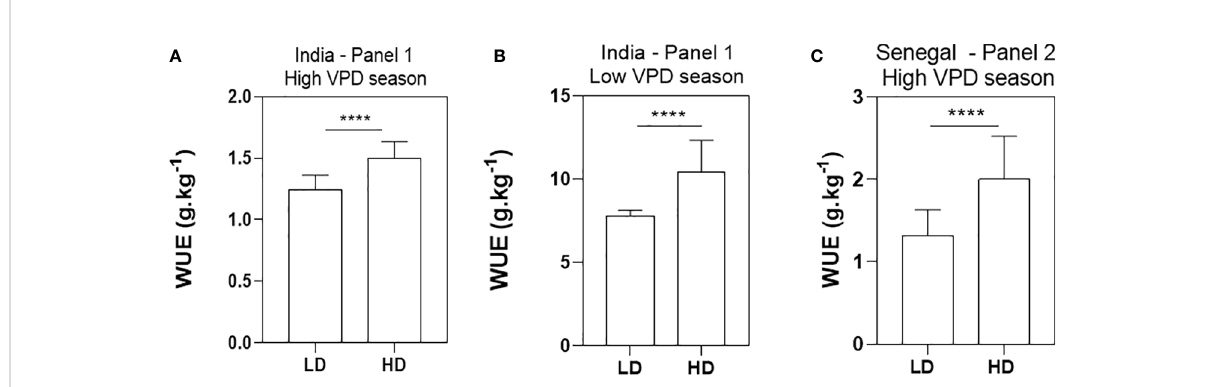
FIGURE 5 Water use ef fi ciency (WUE) in grams of biomass per kilograms of water use in the low density (LD) and high density (HD) treatments. WUE was measured in 20 genotypes in the lysimeter platform in India in 2018 in both the dry (A) and rainy (B) seasons, and in 30 genotypes tested in the Senegal lysimeter platform during the 2021 post rainy season (C) . Data are means and standard deviation of 20 genotypic means in India (A, B) and 30 genotypic means in Senegal (C) . Genotypic mean values were the average of 4 replicated plots in India and 3 replicated plots in Senegal, for each genotype-by-density combination. ****p-value < 0.0001.